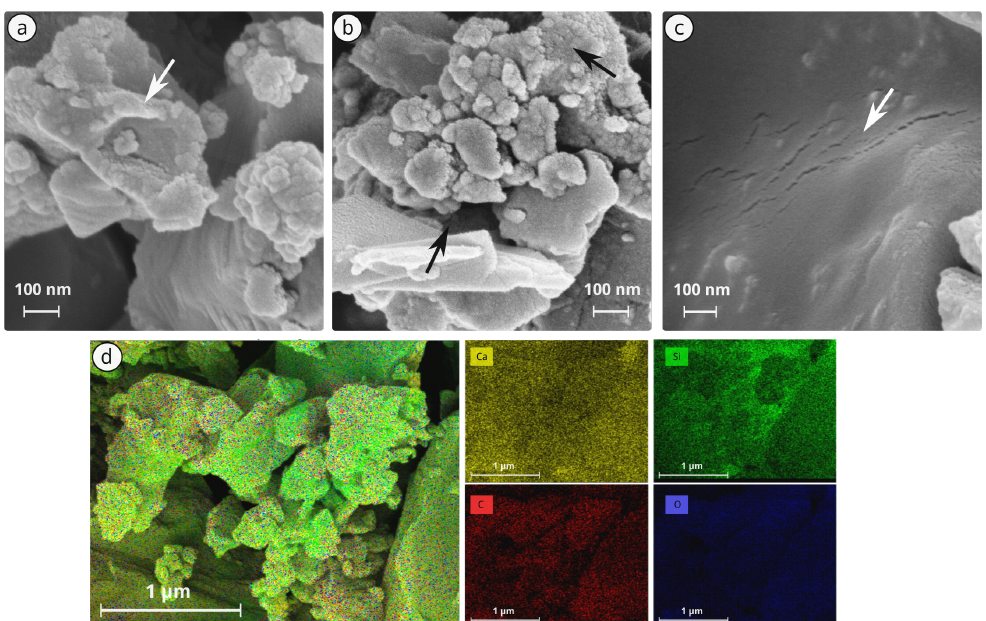
Figure A4. Exemplary SEM micrographs of the stone samples treated with ( a ) HCl-ref, ( b ) HCl:nHAp, and ( c ) HCl:nSiO 2 and ( d ) exemplary EDS results from one of the samples treated with HCl-ref formulation. Arrows indicate the areas where a film covering calcite grains and stone pores is visible or was